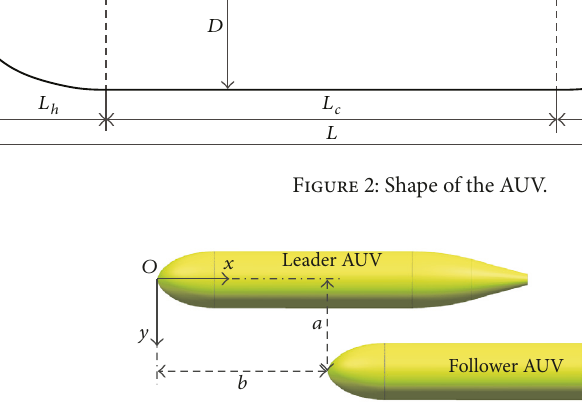
Figure 3: Parameter definition for the AUV